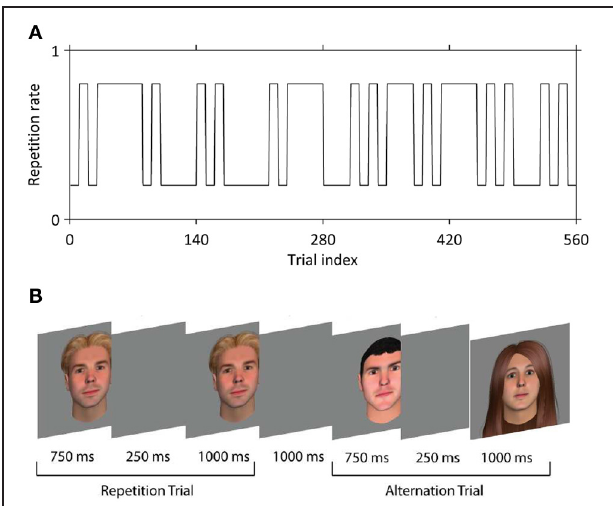
FIGURE 1 | The behavioral paradigm. (A) Example of the manipulation of the repetition probability, which over the experiment alternates between 80% (expect rep trials) and 20% (expect alt trials). (B) In each trial, two faces were presented in succession that were either identical (repeated trials, REP) or different (alternation trials,